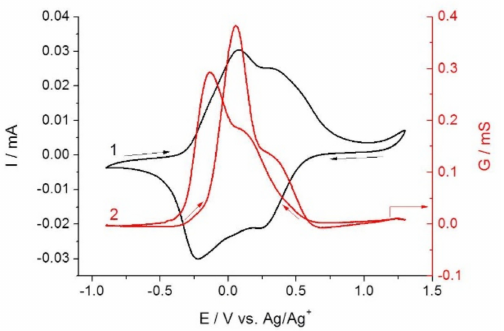
Figure 8. Cyclic voltammogram (black curve 1) and conductance profile (red curve 2) of a poly- [NiAmben]-coated interdigitated electrode in 0.05 M Et 4 NBF 4 /DCE at a scan rate of 0.01 V s − 1